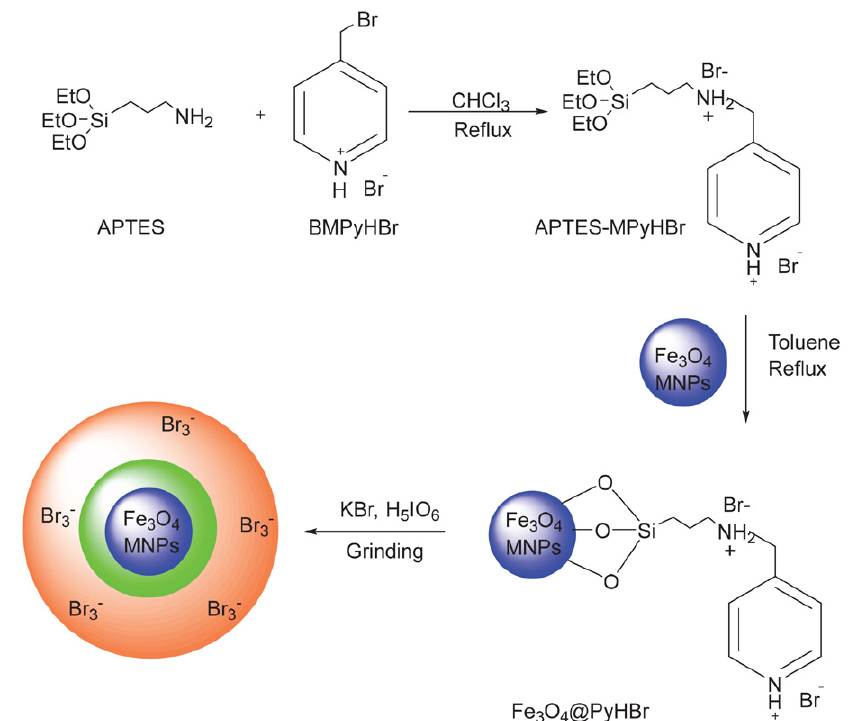
Tabari et al.: Magnetic Nanoparticles Linked